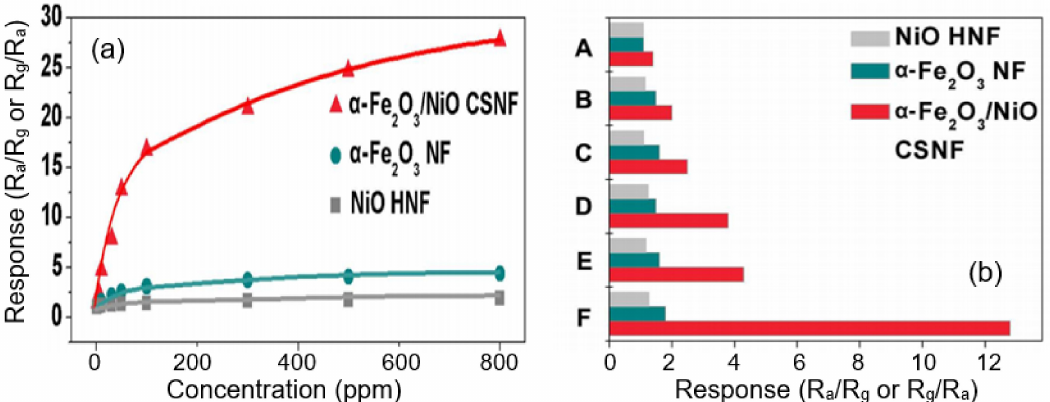
Figure 21. ( a ) Responses of the sensors based on NiO HNF, α -Fe 2 O 3 NF and α -Fe 2 O 3 /NiO CSNF to HCHO gas ( T oper = 240 ◦ C); ( b ) the selectivity of α -Fe 2 O 3 /NiO CSNF, α -Fe 2 O 3 NF and NiO HNF to 50 ppm different gases ((A) ethyne, (B) ammonia, (C) trichloromethane, (D) methylbenzene, (E) ethanol, (F) formaldehyde). Reprinted with permission from [255]. Copyright 2015 RSC. Table 7. Some sensing properties of composite and heterostructure-based electrospun metal oxide NFs.